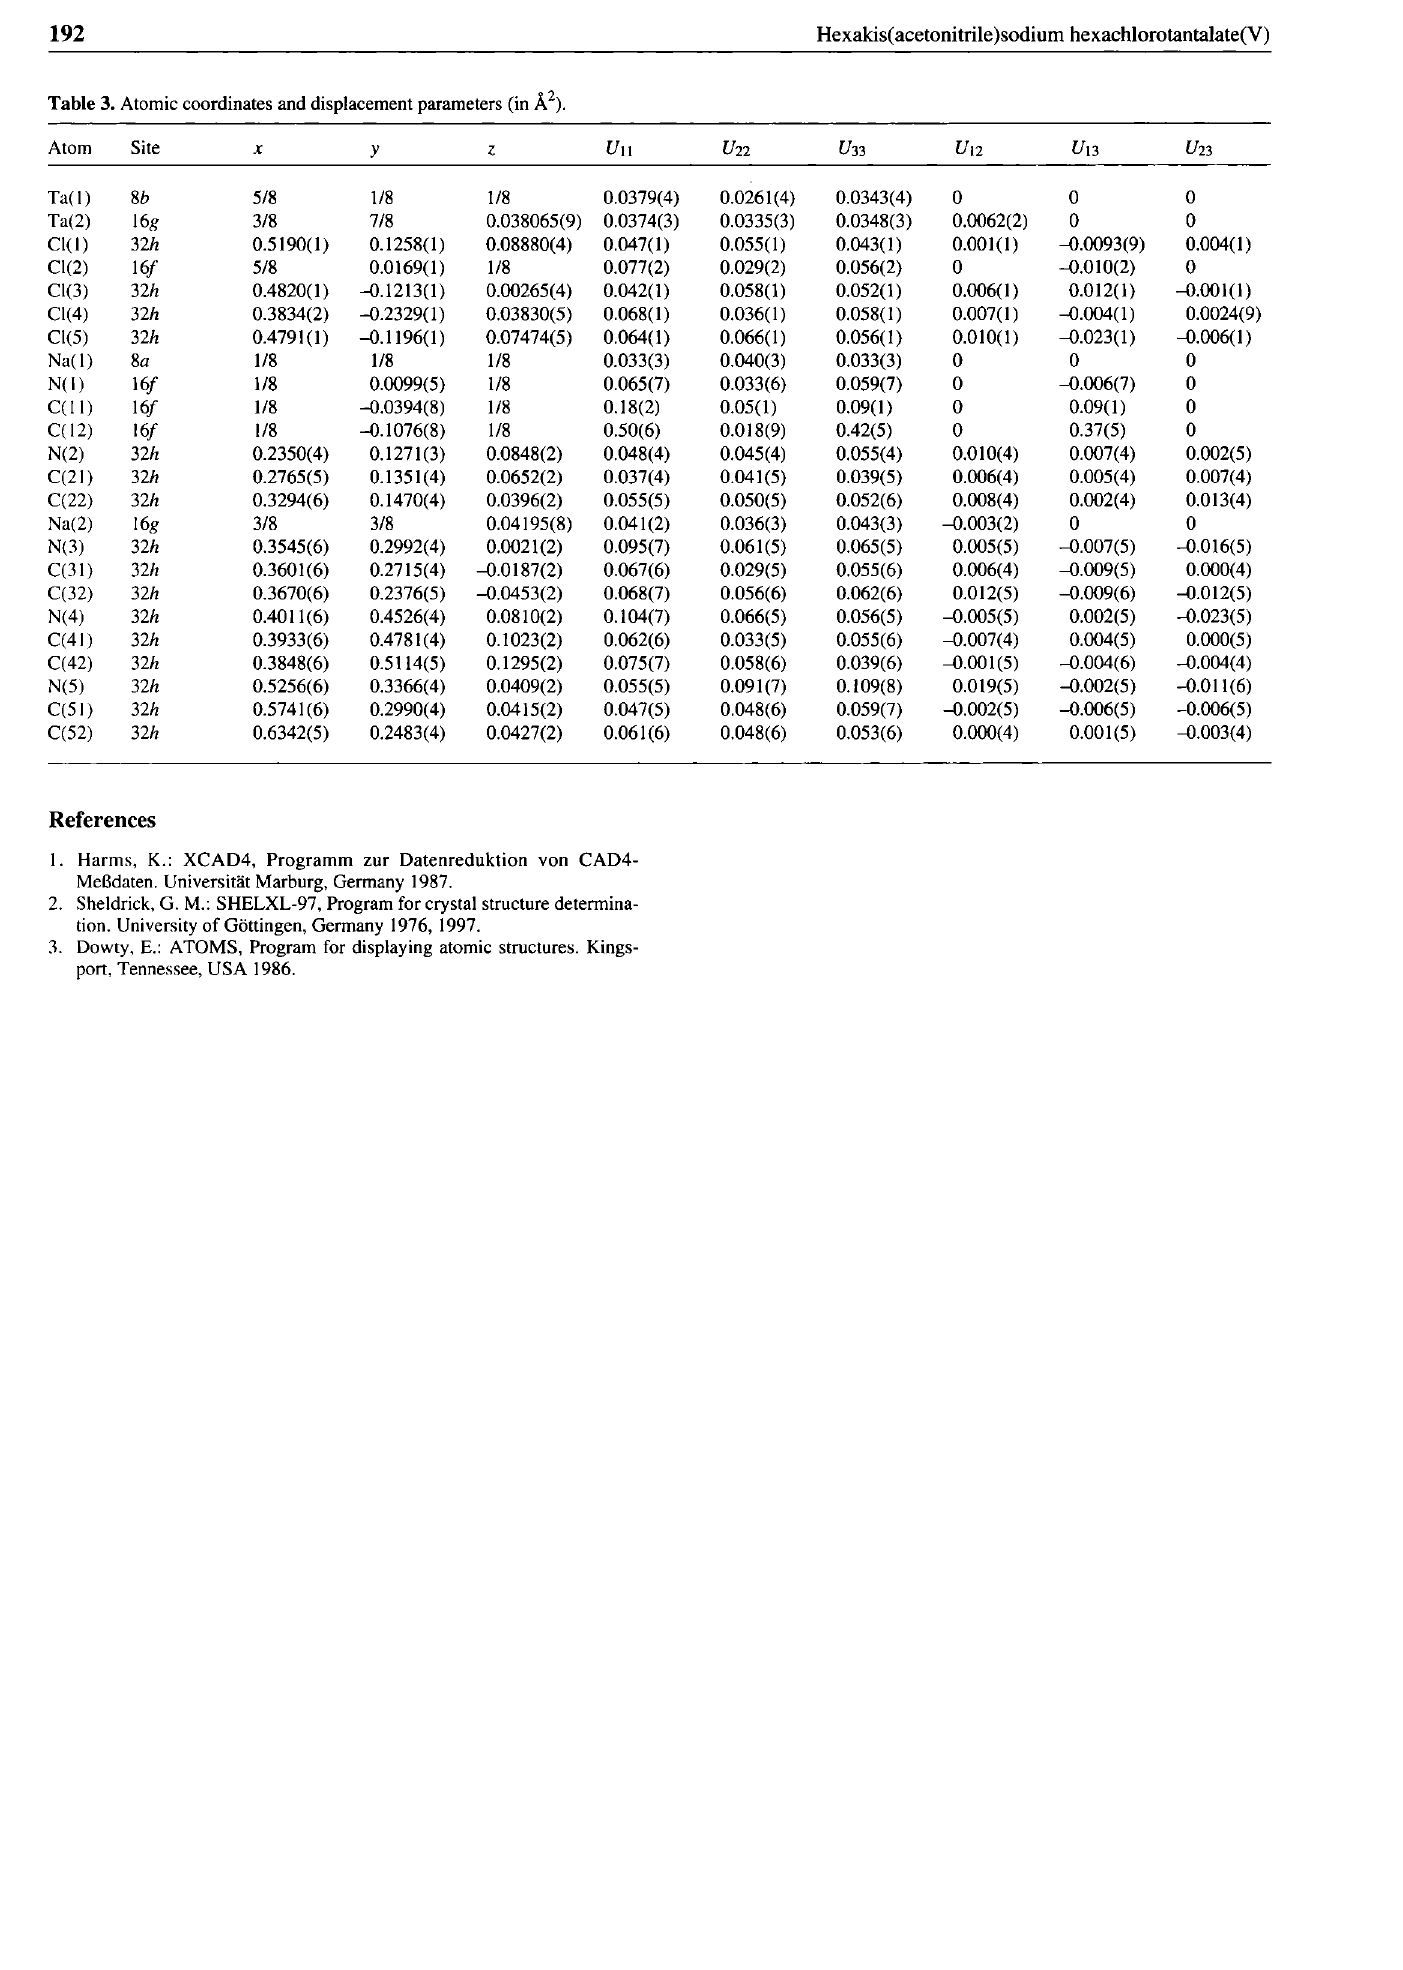
Table 3. Atomic coordinates and displacement parameters (in Ä 2